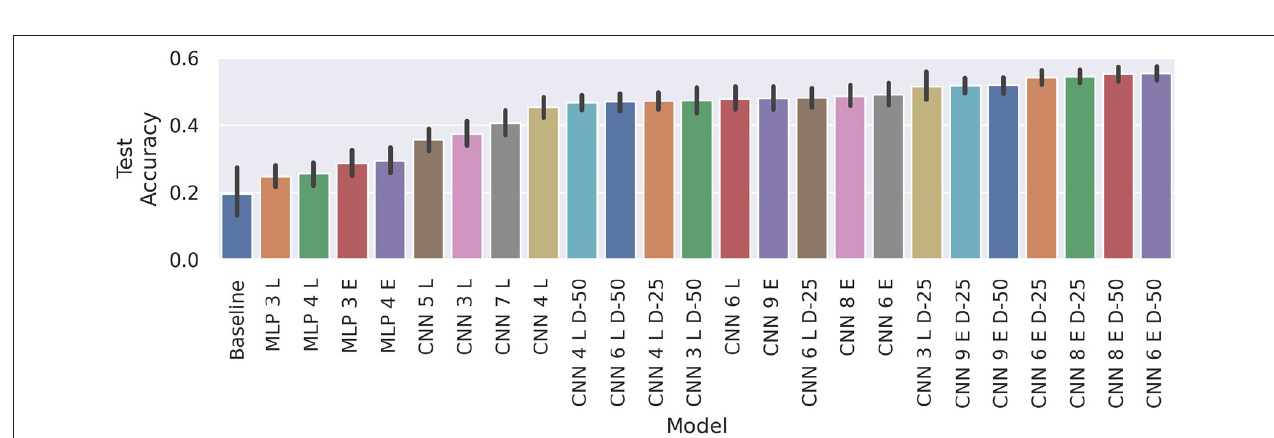
FIGURE 12 | Comparison of average cross-session test accuracy on subject E with and without calibration. The black vertical lines display the 95% confidence intervals, whereas the red dotted line represents the average baseline score. Every train/test setup was repeated five times for each model, to account for variability due to random weight initialization.